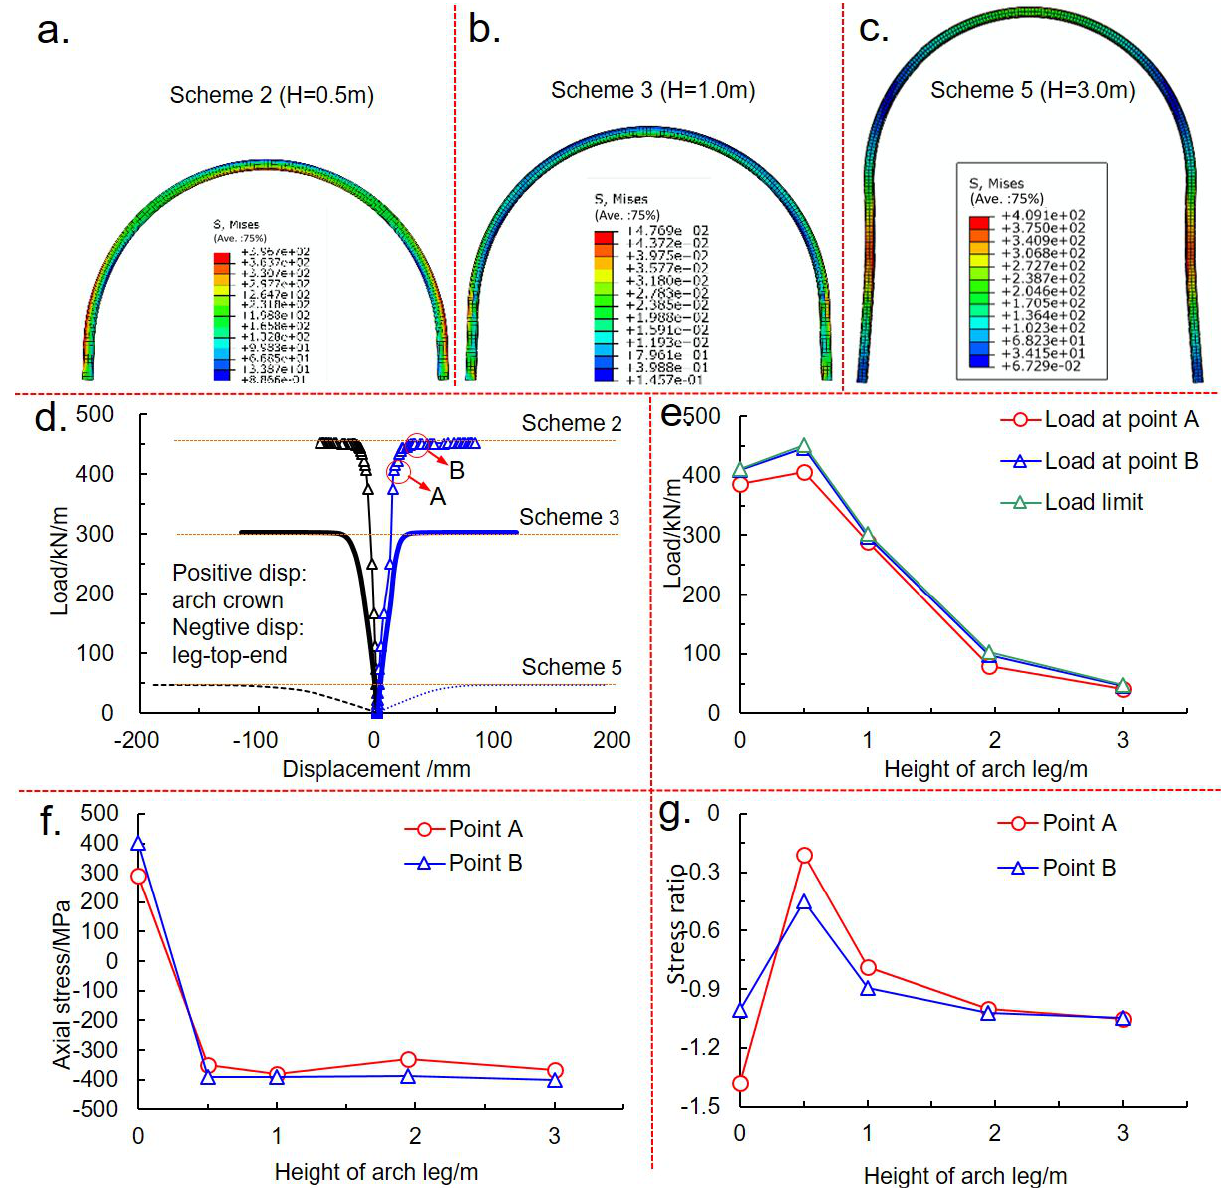
Figure 6: Typical results of Schemes 1–5 with different leg heights. (a)–(c) Stress contours and deformed shapes of the arches; (d) Load- radial displacement curves; (e) Characteristic loads influenced by the leg heights; (f) Axial stress at the dangerous section, influenced by the leg height; (g) Ratio of the axial stress at the inner and outer sides of the dangerous section, influenced by the leg